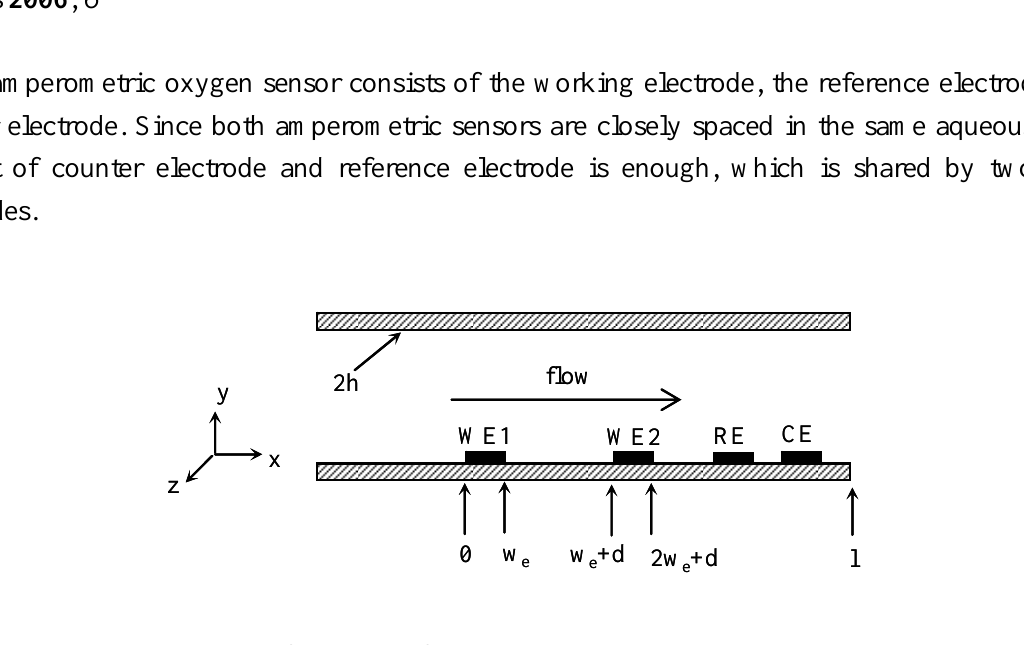
Figure 1. The coordinate of the nano flow sensor during simulation. The upstream amperometric sensor and downstream amperometric sensor share common counter and